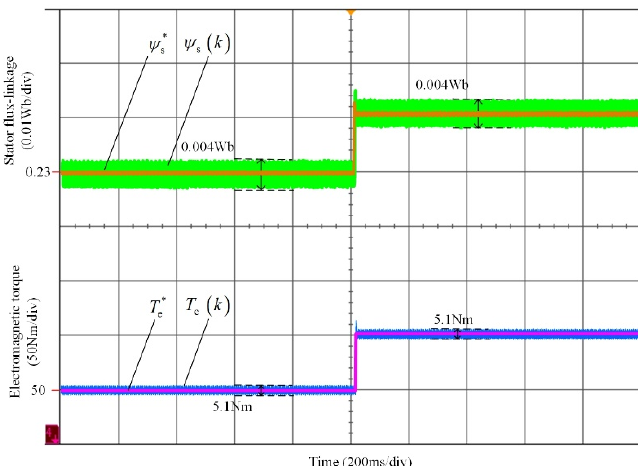
Figure 11. The curves of stator flux-linkage and electromagnetic torque for the proposed MPDTC.